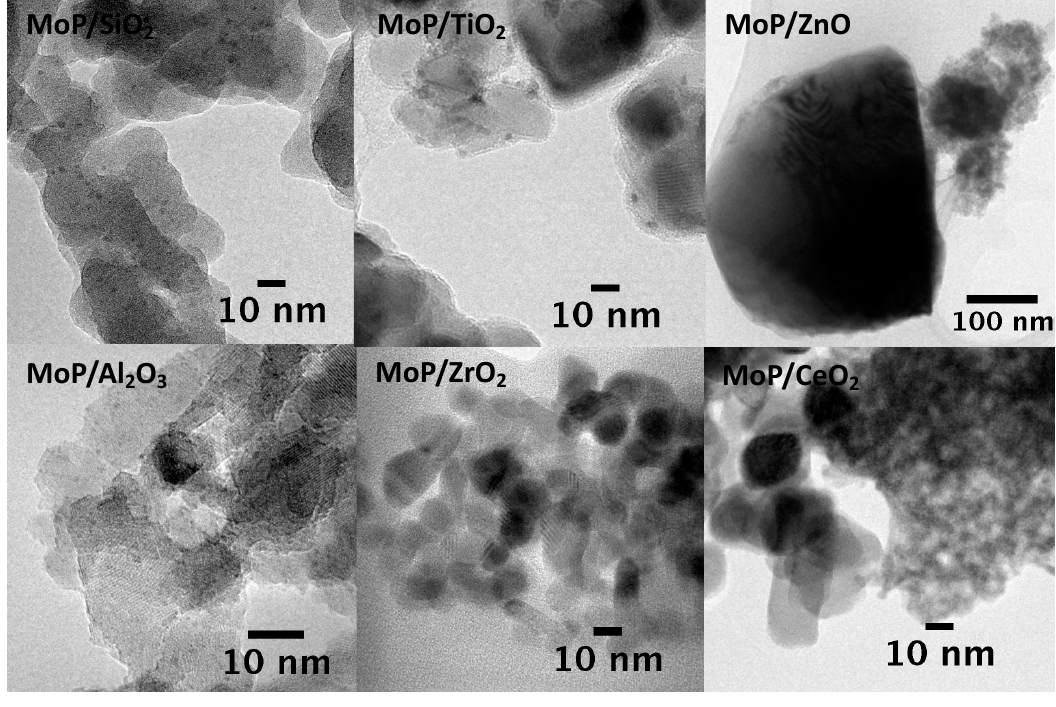
Figure 4. TEM image showing nanoparticles supported on SiO 2 , TiO 2 , ZnO, Al 2 O 3 , ZrO 2 , and CeO 2 . All catalysts underwent a reduction treatment in pure hydrogen at 450 °C for 1 h prior to imaging.